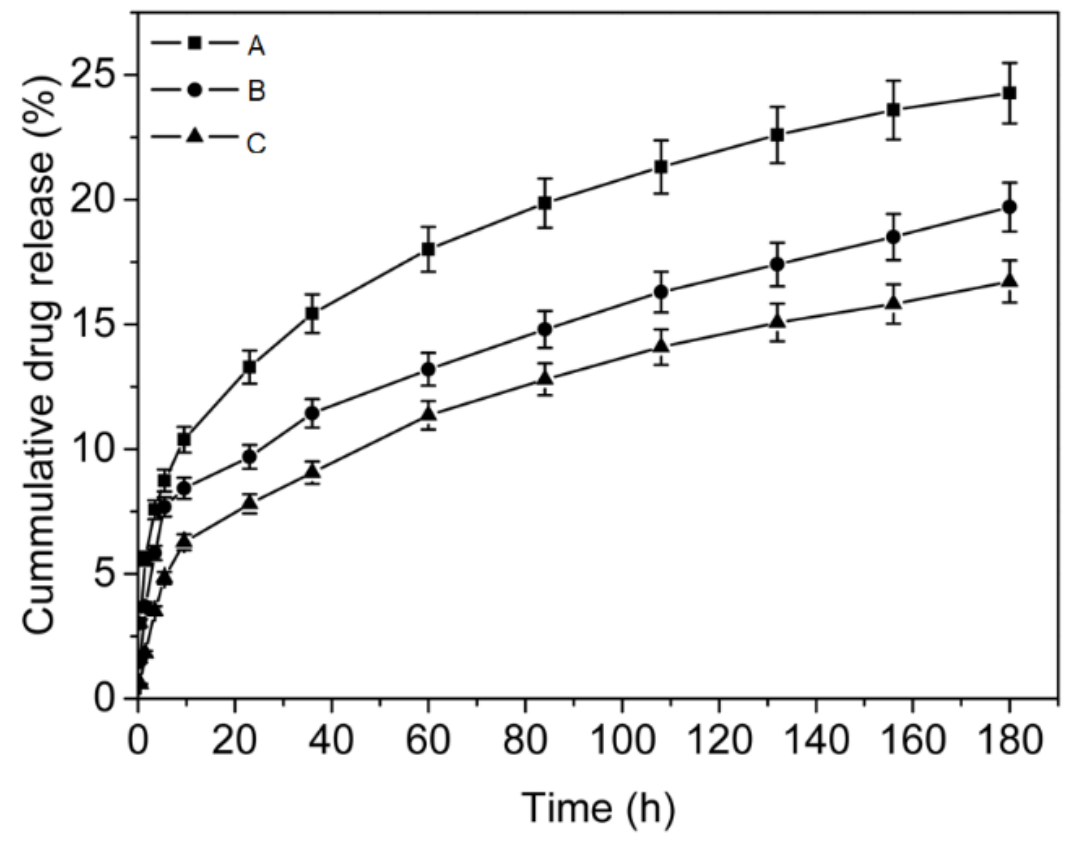
Figure 6. Drug release profiles of prednisone acetate-loaded m PEG-HTO- m PEG micelles (A: m PEG- HTO- m PEG-1; B: m PEG-HTO- m PEG-2; C: m PEG-HTO- m PEG-3).